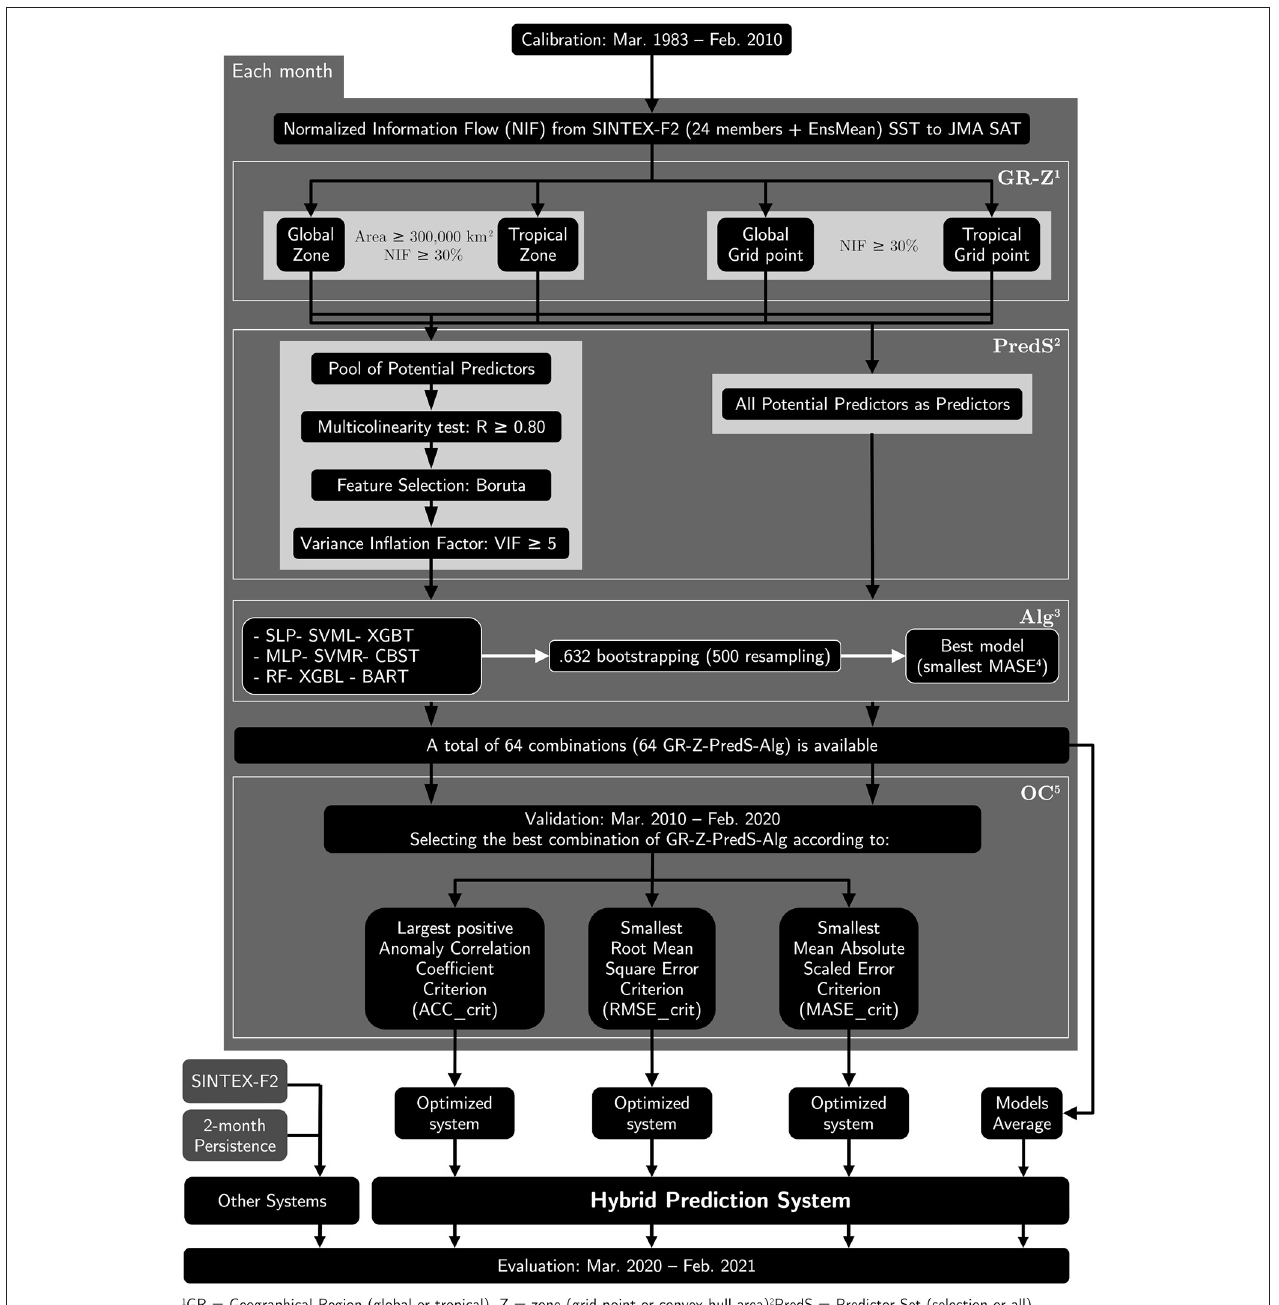
FIGURE 3 | Workflow of the hybrid prediction system (HPS). For each month, the general process consists of NIF calculation, followed, in order, by the selection of geographical region and zones (GR-Z), the selection of predictors (PredS), the calibration of models through different machine learning algorithms (Alg), and the optimal configuration (OC) ending to the creation of HPS. SLP and MLP are artificial neural network with single- and multi-layer perceptron, respectively; SMVL and SVMR are the support vector machine with linear and radial kernels, respectively; RF is the random forest; XGBL and XGBT are extreme gradient boosting with linear and tree-based approaches, respectively; CBST is CatBoost and BART is Bayesian additive regression